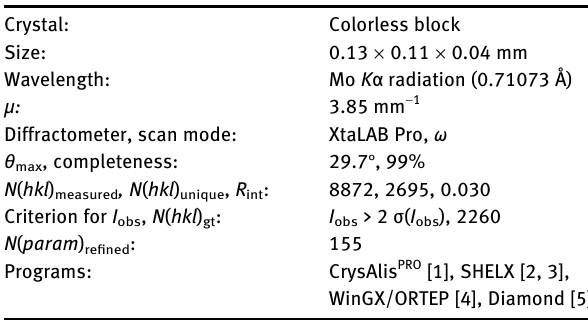
Table 1 contains crystallographic data and Table 2 contains the list of the atoms including atomic coordinates and displacement parameters.